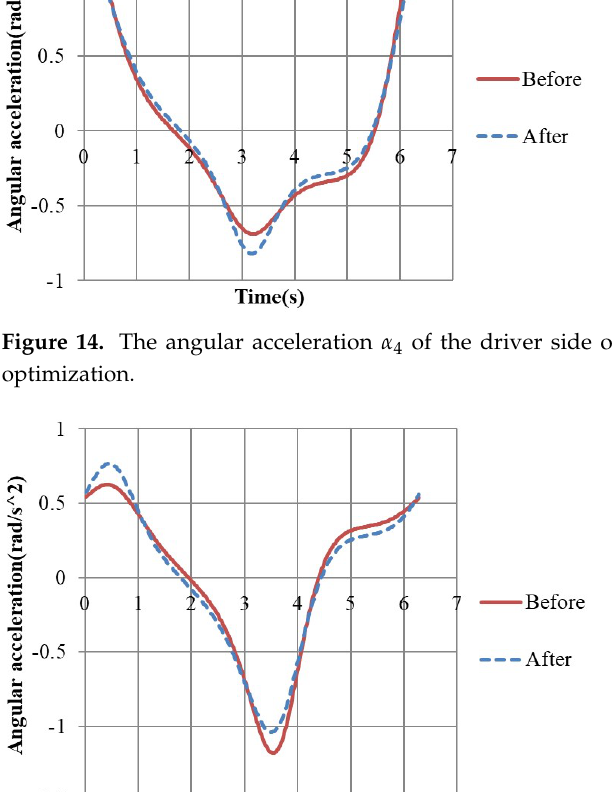
of the passenger side output-link of CDLS before/after 6